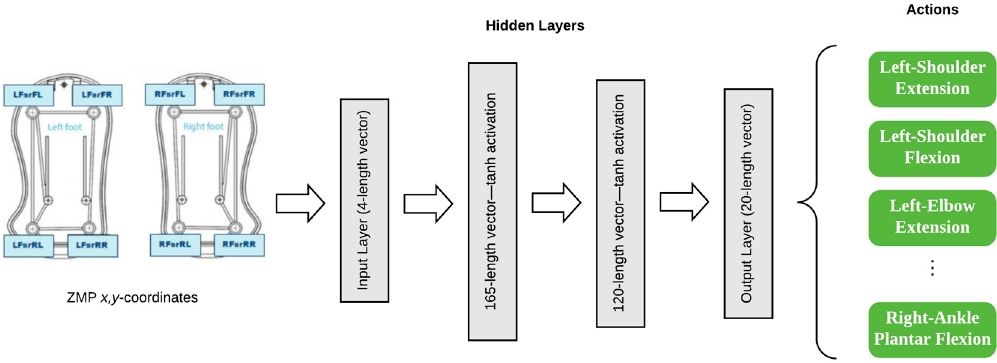
Figure 7. First Level Q-Network.